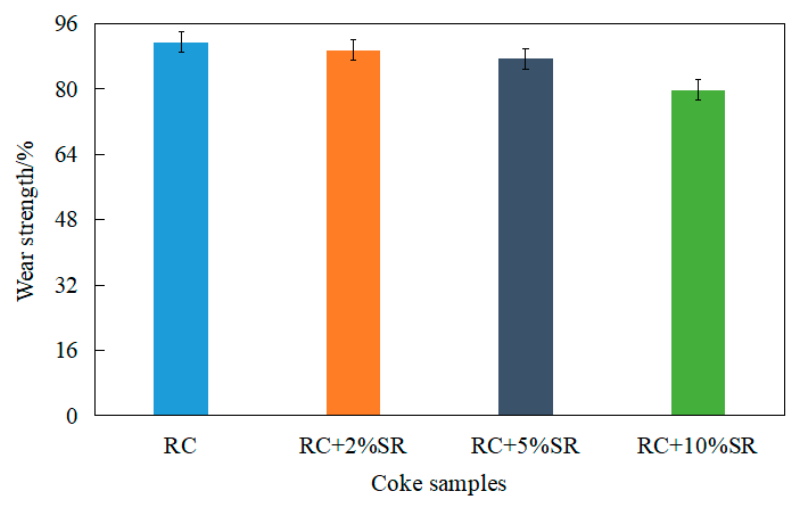
Figure 11. The wear strength of the coke samples.